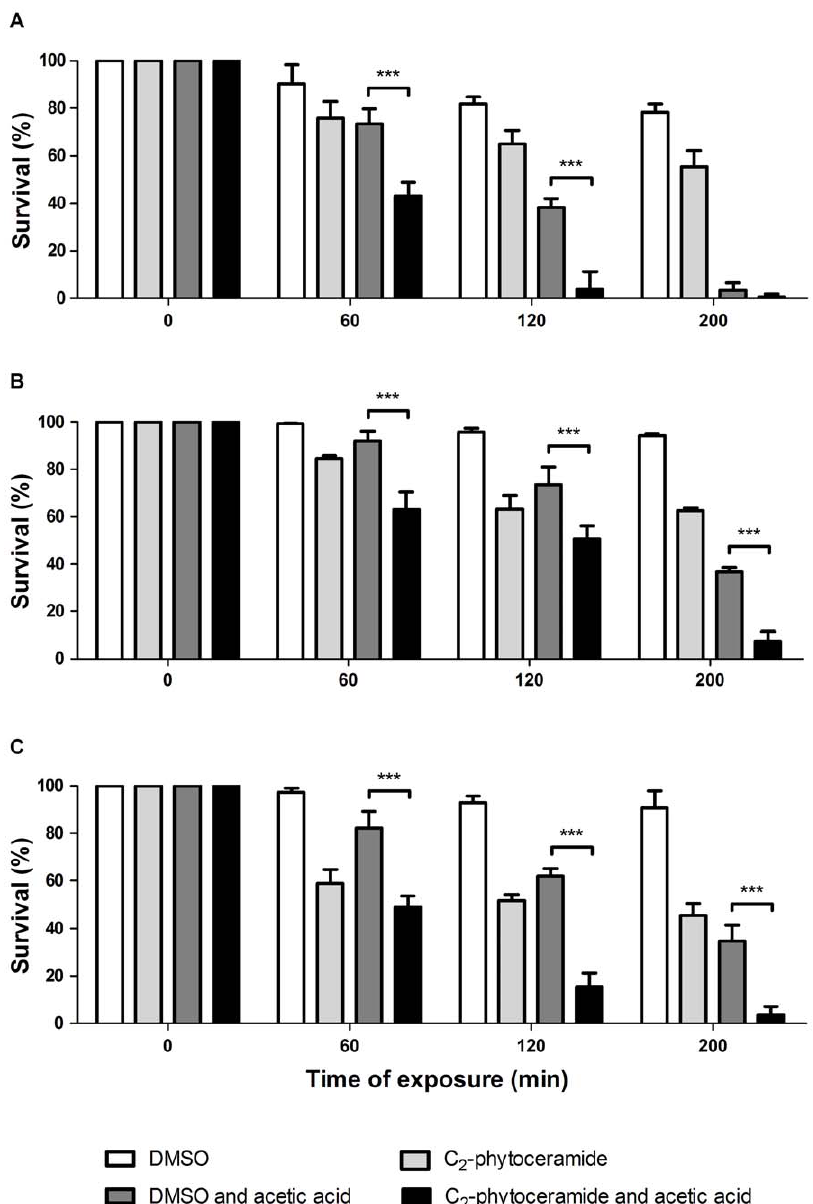
Figure 7. Effect of exogenous C 2 -phytoceramide. Survival of S. cerevisiae strain CG379 (A), lag1 D (B) and isc1 D (C) exposed to DMSO, 15 m M of C 2 -phytoceramide, 180 mM acetic acid or 15 m M of C 2 -phytoceramide and 180 mM acetic acid, for up to 200 min. Cell viability was determined by standard dilution plate counts and expressed as a percentage of c.f.u on YPD plates. Values are mean 6 SD of at least three independent experiments. Values significantly different: *** P , 0.001, One-way ANOVA and Tukey Test.